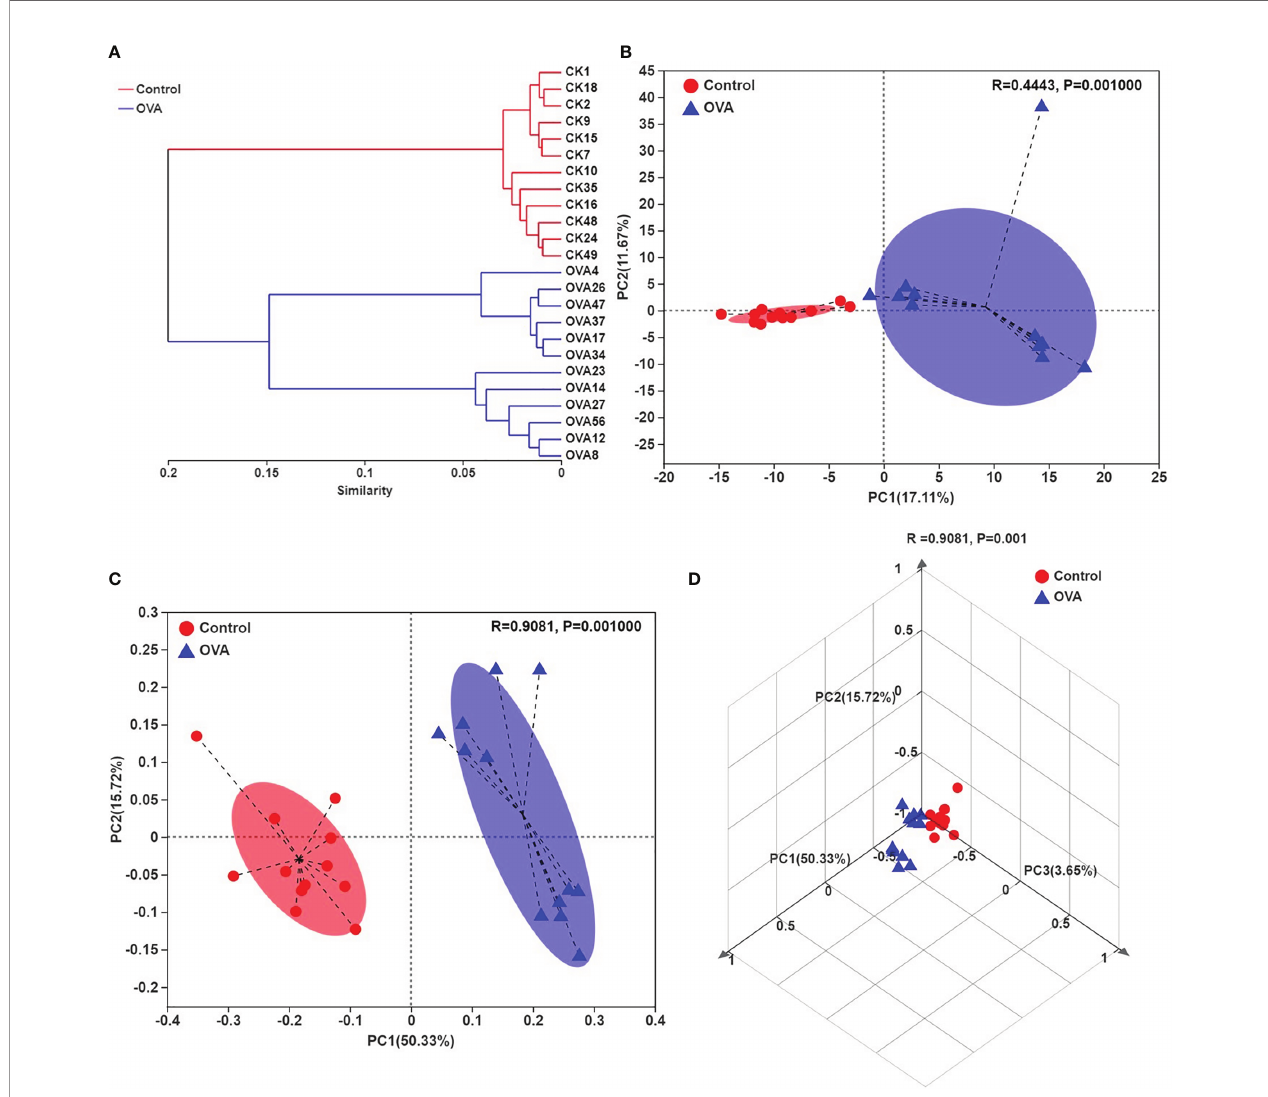
FIGURE 5 | Hierarchical clustering tree on OUT level (A) , Principle component analysis (PCA) plots (B) , and principal coordinate analysis (PCoA) plots (C, D) on OUT level of all samples. (C, D) indicate the two- and three-dimensional PCoA